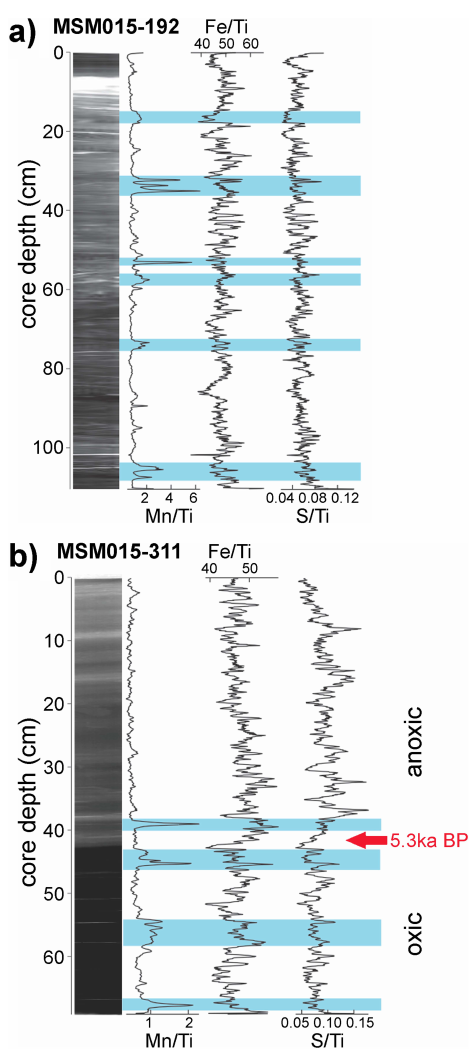
Fig. 18. X-ray radiographic images and XRF element (Mn, Fe, S) /Ti profiles of sediment cores in the Bosporus outflow area of the Black Sea (see Fig. 1 for location). Positive Mn/Ti peaks reflect oxic conditions, whereas positive S/Ti peaks indicate anoxic conditions at the time of deposition. The cores were taken at 307m water depth, which is below the present oxic/anoxic interface. The Mediter- ranean Water ventilation effect is indicated by positive Mn/Ti peaks (marked by blue bands). (a) Core MSM015-192 is located in the eastern part of the area (41 ◦ 30.143 0 N, 29 ◦ 16.340 0 E). This core shows high Mn/Ti throughout the core, indicating the ventilating role of the Mediterranean water. (b) Core MSM015-311 is located in the western part of the area (41 ◦ 34.7842 0 N, 29 ◦ 03.462 0 E). The X-ray radiographic image of this core shows an abrupt change in density at 42cm, dated at 5.3ka BP. This change is accompanied by the termination of positive Mn/Ti peaks, suggesting that the venti- lation by Mediterranean water in the western part of the area ceased around 5.3ka